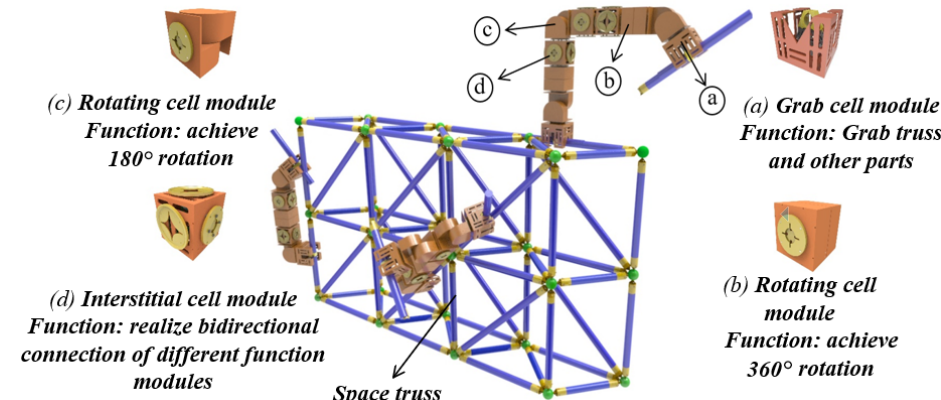
Figure 2. Schematic diagram of spatial cellular robot truss assembly.